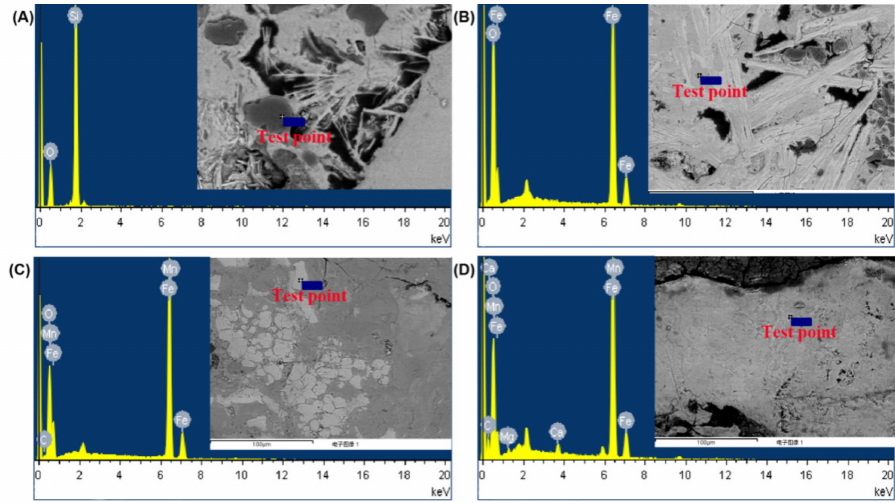
Figure 7. EDX spectrum. The iron anchor samples detected silica ( A ), ferric oxide ( B ), ferric oxide ( C ), and ferrous oxide and calcium–magnesium carbonate ( D